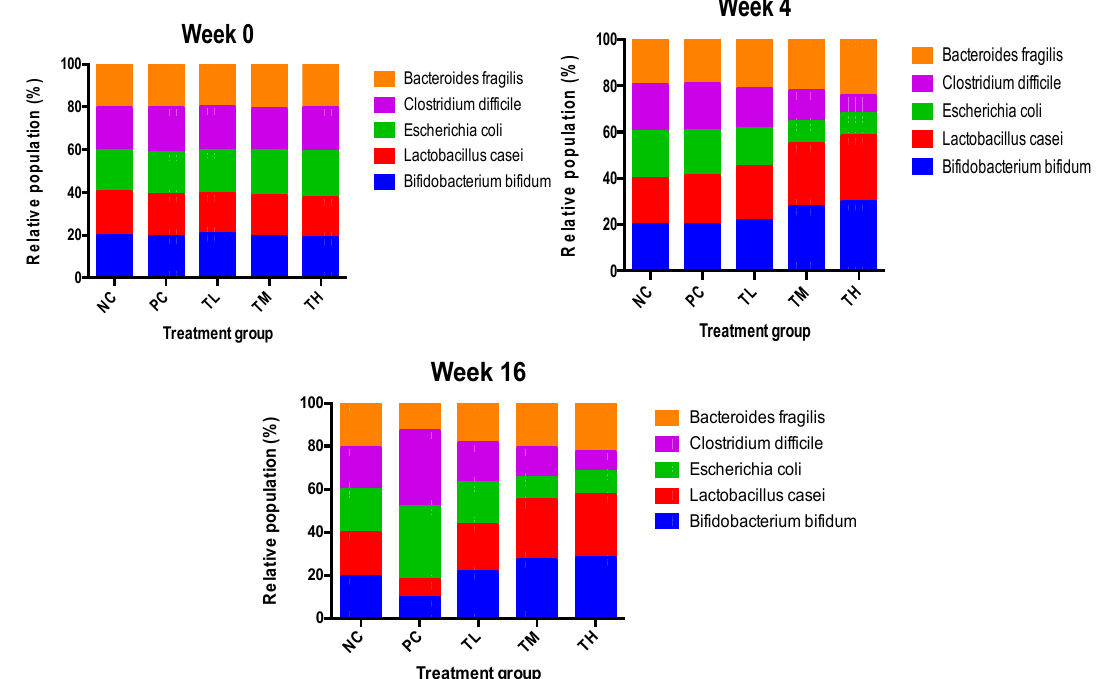
Figure 10. Effect of prebiotic IMD on the relative percentage change of each bacterium compared to the total bacteria population in LPS-induced low-grade inflammatory mice. NC, negative control (untreated mice); PC, positive control (mice treated with LPS); TL, treatment low (mice treated with 1% IMD and LPS); TM, treatment medium (mice treated with 2.5% IMD and LPS); TH, treatment high (mice treated with 5% IMD and LPS). The stacked bar graph is presented as the relative percentage of B. bifidum, L. casei, E. coli, C. difficile, and B. fragilis on week 0, 4, and 16 ( n = 6).